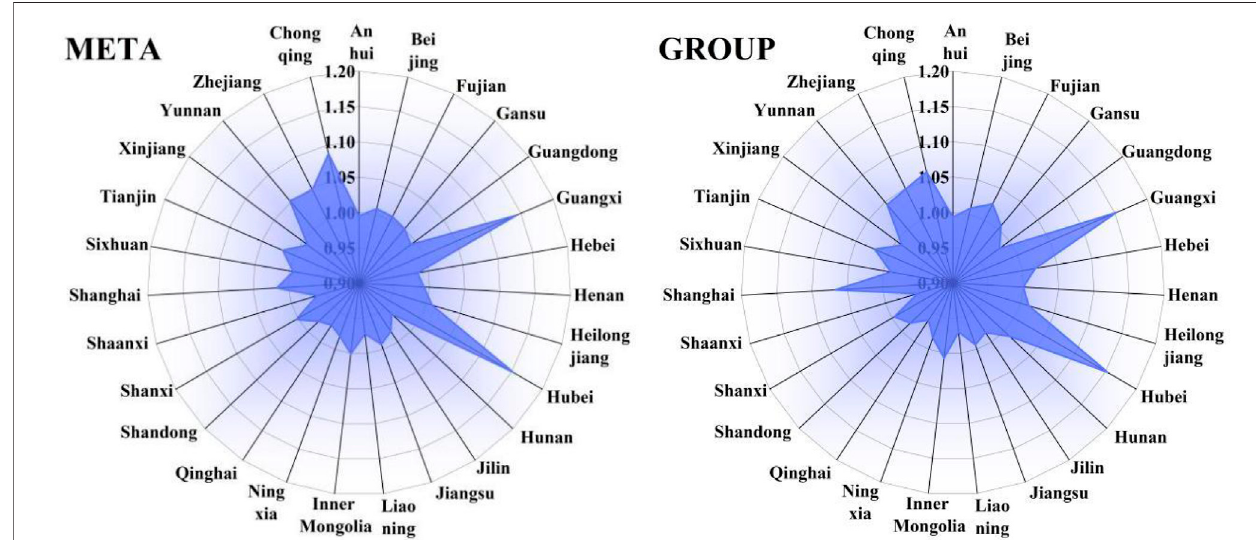
FIGURE 8 | Average GMLMI in each